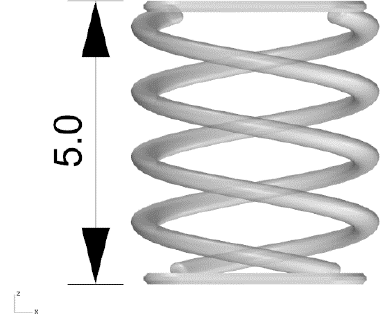
Figure 2. 3D geometry of the micrometric spring. Dimension is expressed in mm.